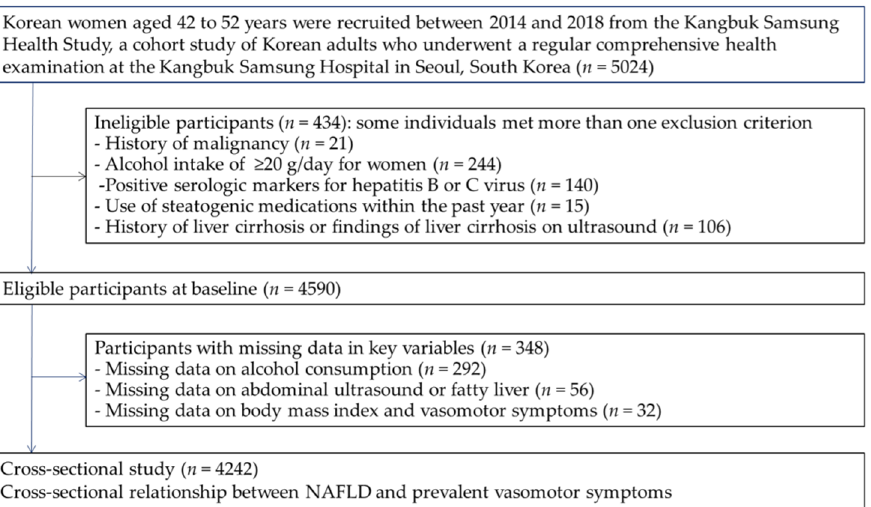
Figure 1. Flowchart of the study population.